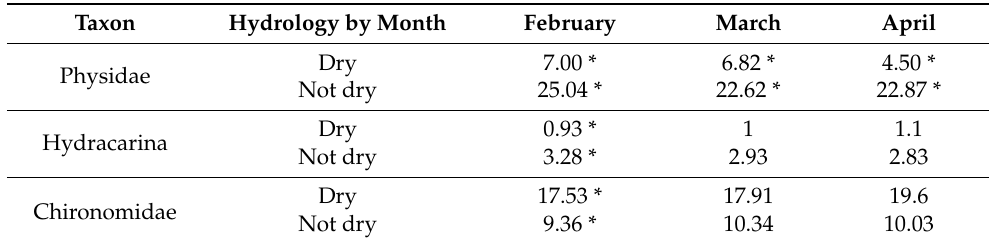
Table 7. Average number of organisms by taxa in all mesocosms that were affected by dry and wet conditions by month in